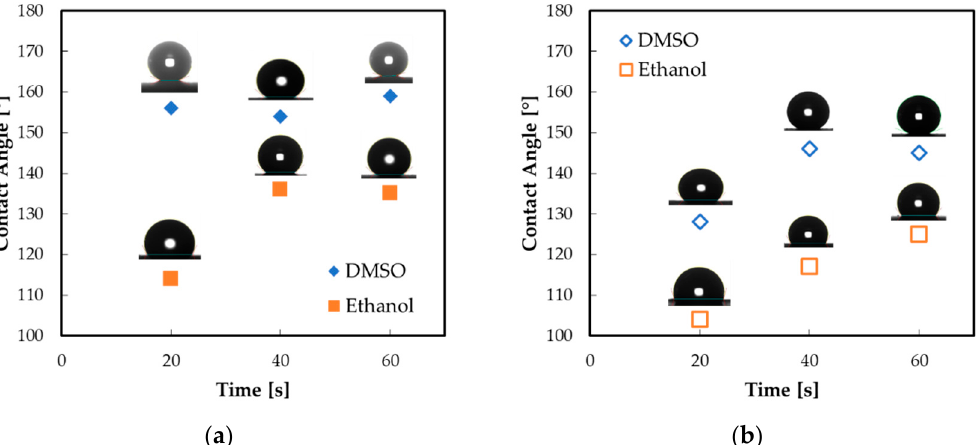
Figure 1. Contact angle values, as function of electrodeposition time, for SS samples after the electrodeposition process using two different solvents with ( a ) mirror-like and ( b ) 2B G320 surface finishing.